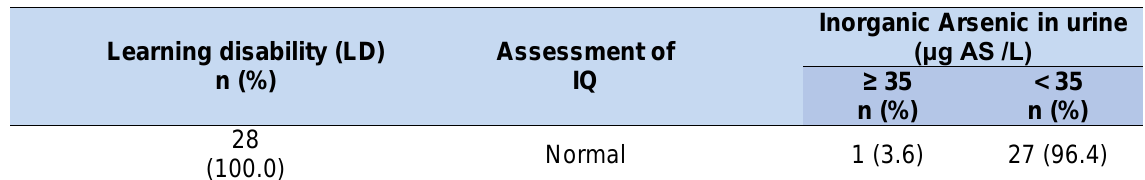
Table 3: Number and percentage of inorganic arsenic in urine of 28 children that had a learning disability (LD)